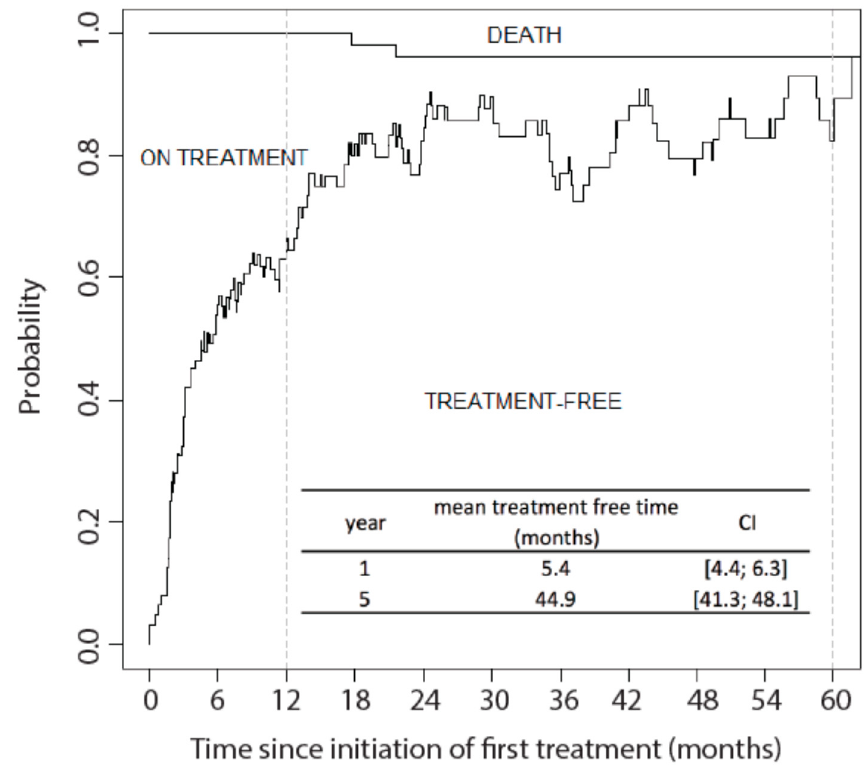
Figure 4. Treatment free time after systemic treatment initiation in classic/endemic KS. This figure was generated using state occupation probabilities: the area under the curve represents the mean time spent alive, on treatment and alive treatment-free during the first 5 years following the initiation of first systemic treatment. The inset table reports the mean times spent treatment free during the first year and the first 5 years following the initiation of first systemic treatment in the whole cohort, with their 95% CI. Dotted lines correspond to 1 and 5 years after first treatment.